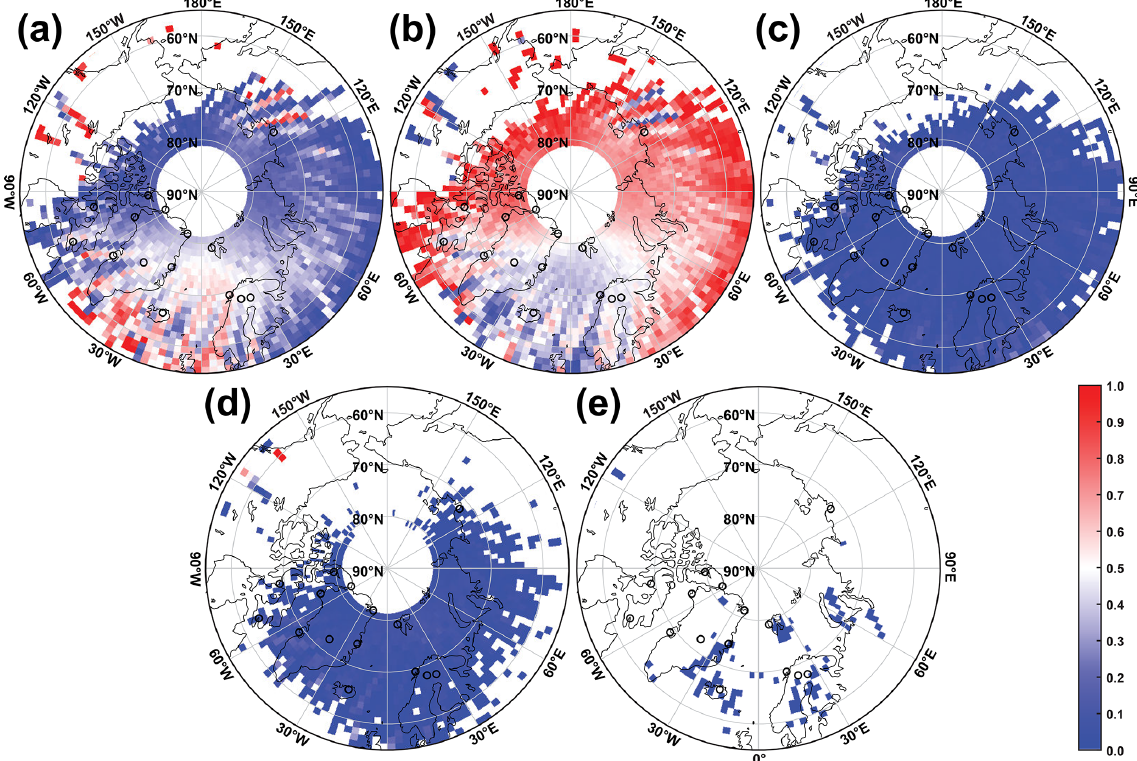
Figure 3. Normalised occurrence rate of CALIPSO height bins that contain (a) STS, (b) NAT mixture, (c) NAT enhanced, (d) ice, and (e) wave ice for all-sky conditions in the Arctic.